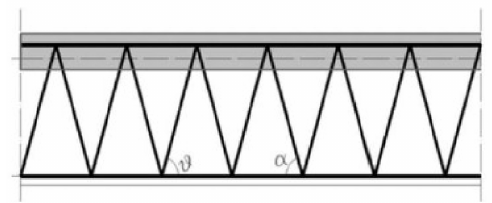
Figure 21. Scheme of the truss system according to Amadio et al.